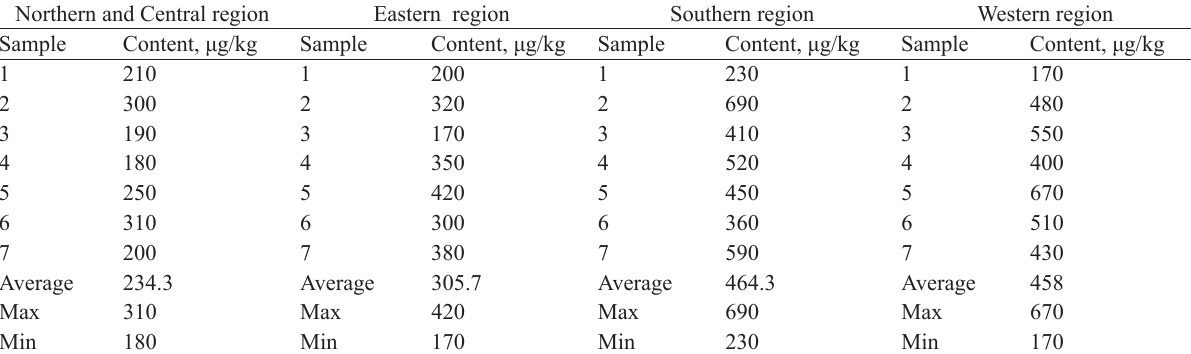
Table 5 Copper contents in raw milk samples Northern and Central region Eastern region